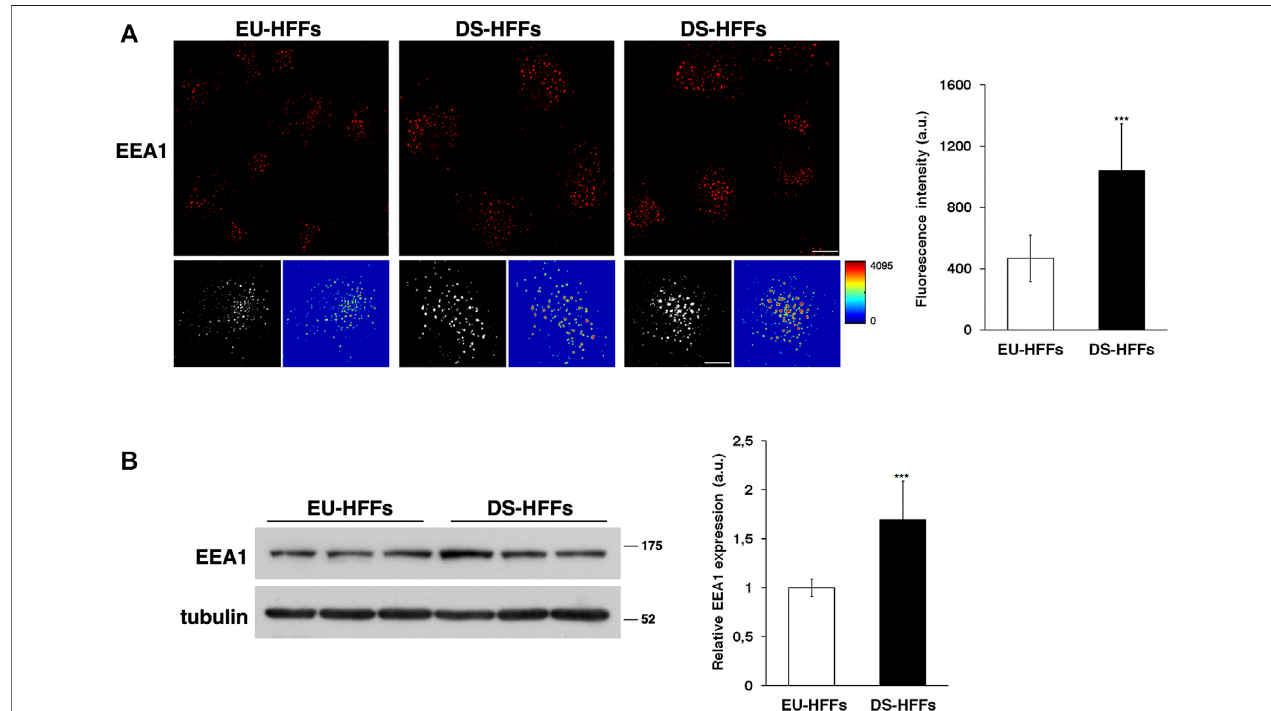
FIGURE 1 | The homeostasis of early endosomes is altered in DS fetal fi broblasts. (A) Human fetal fi broblasts from euploid (EU-HFFs) and DS (DS-HFFs) fetuses were stained with early endosome antigen 1 (EEA1) antibody detected with Alexa-546-conjugated secondary antibodies. Serial confocal sections were collected from the top to the bottom of the cells. Representative images showing that the early endosomes are enlarged in trisomic cells when compared to euploid cells. For each condition, the 3D reconstruction and corresponding intensity map are shown. Scale bars, 8 μ m. The mean fl uorescence intensity (arbitrary unit, a.u.) of EEA1- positivestructuresishigherinDS-HFFsthaninEU-HFFs.Thebarsshowtherelativemeanvalue±SDofthreeindependentexperiments, n ≥ 50cells. (B) Representative immunoblottingofEEA1inDS-HFFsandEU-HFFs.Tubulinwasusedastheloadingcontrol.Themolecularweightofproteinmarkersisindicated.Densitometricanalysis of three different experiments, performed in three euploid and in four trisomic cultures, is shown. Error bars, mean ± SD. *** p < 0.001, Student ’ s t